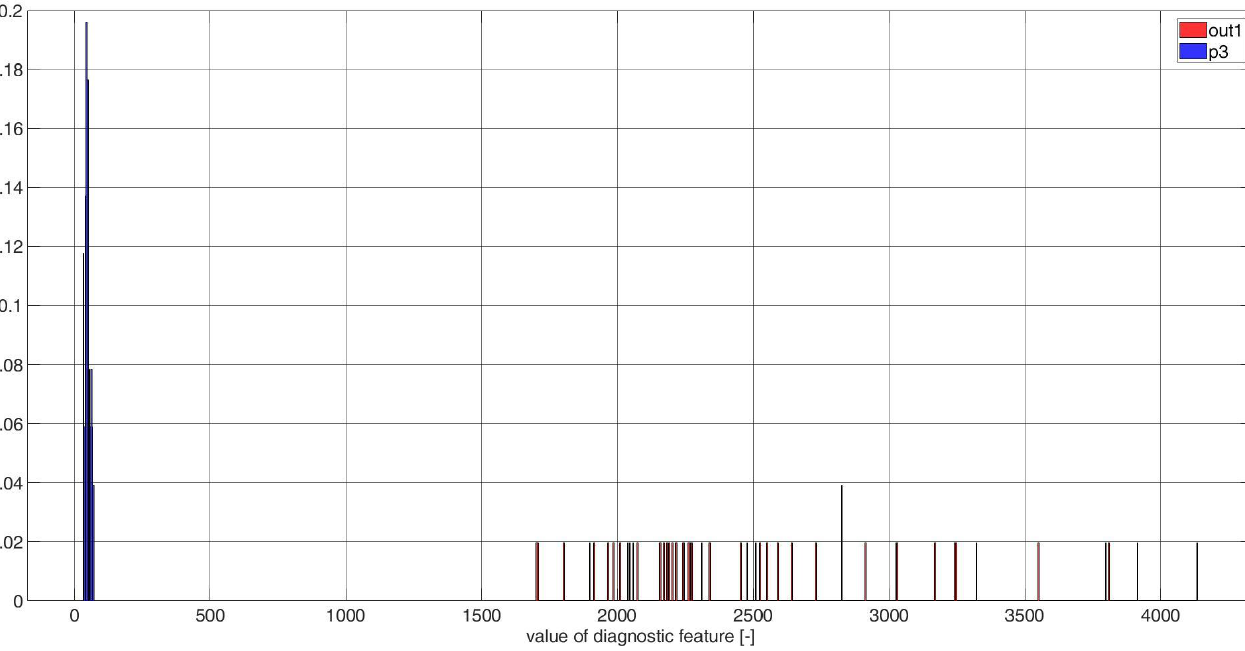
Figure A29. Histograms of diagnostic features based on the CCSM3 (correlation number is 2 — Table A2) bearings out1 and p3.